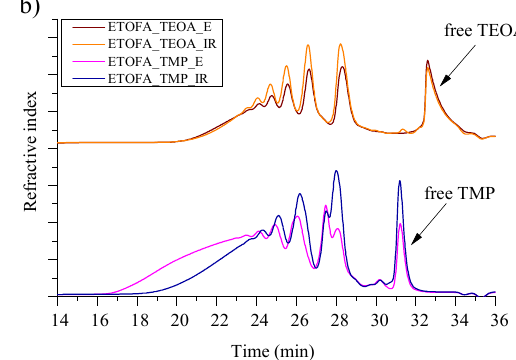
Table 4. The common characteristic of developed rigid PU foams based on TOFA-type bio-poly- ols.